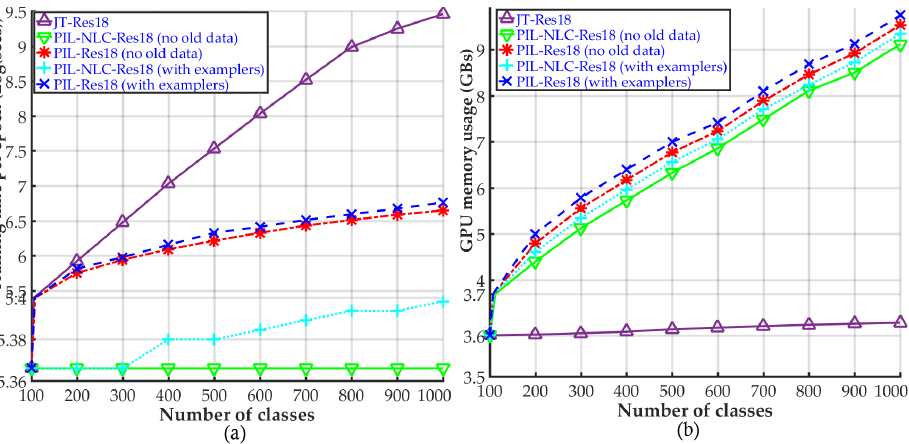
Figure 4. ( a ) Training time and ( b ) GPU memory utilization comparison between the joint training (JT), PIL-NLC and proposed PIL methods on ImageNet-1000